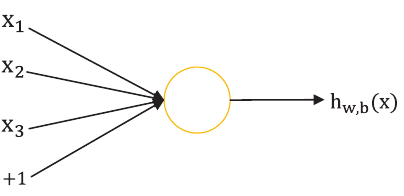
Figure 1. M-P neural network with one neuron and three input nodes